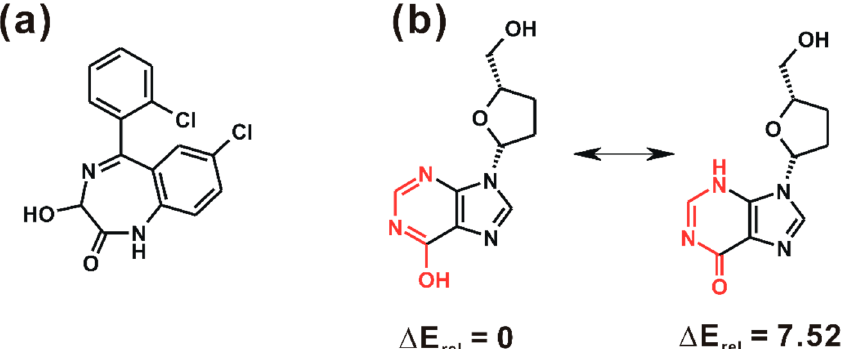
Figure 5. ( a ) Molecular structure of 1 and ( b ) schematic representation of the tautomeric transformation of 2 . Relative electronic energies ( Δ E rel ) calculated at the RHF/6-31G** level of theory are given in kcal/mol. Indicated in red are the atoms involved in the tautomeric change.